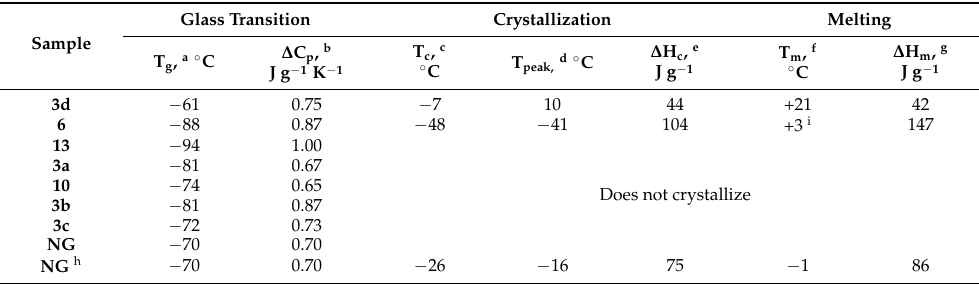
Table 2. Data on glass transition, crystallization and melting of azides and NG (a 10 ◦ C min − 1 ramp